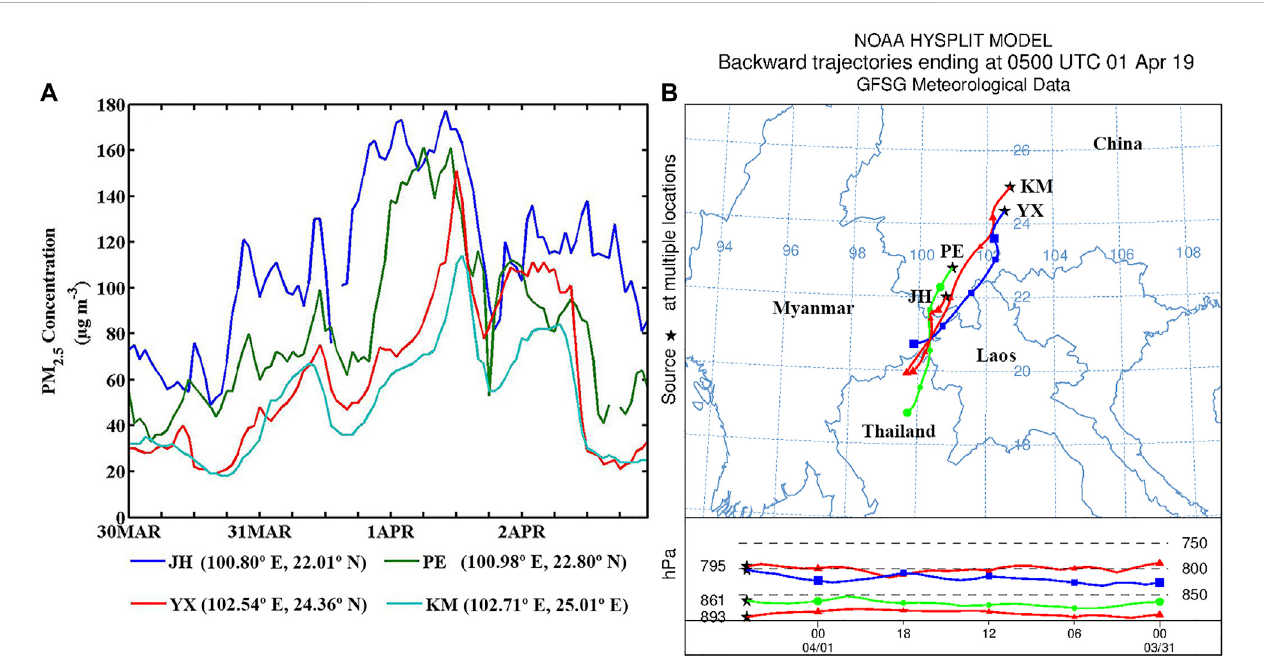
FIGURE 4 (A) The observed hourly concentrations of PM 2.5 ( μ g m − 3 ) in Jinghong (JH,100.80 ° E, 22.01 ° N), Puer (PE, 100.98 ° E, 22.80 ° N), Yuxi (YX, 102.54 ° E, 24.36 ° N) andKunming(KM,102.71 ° E,25.01 ° E)from30Marchto2April,2019. (B) The29-hbackwardtrajectoriesofairparcelsendingat0 maltitudeabovegroundlevel over 4 sites at 05:00 UTC on 1 April, when the hourly maximum of PM 2.5 appeared in Kunming. Note that trajectories were colored with ending